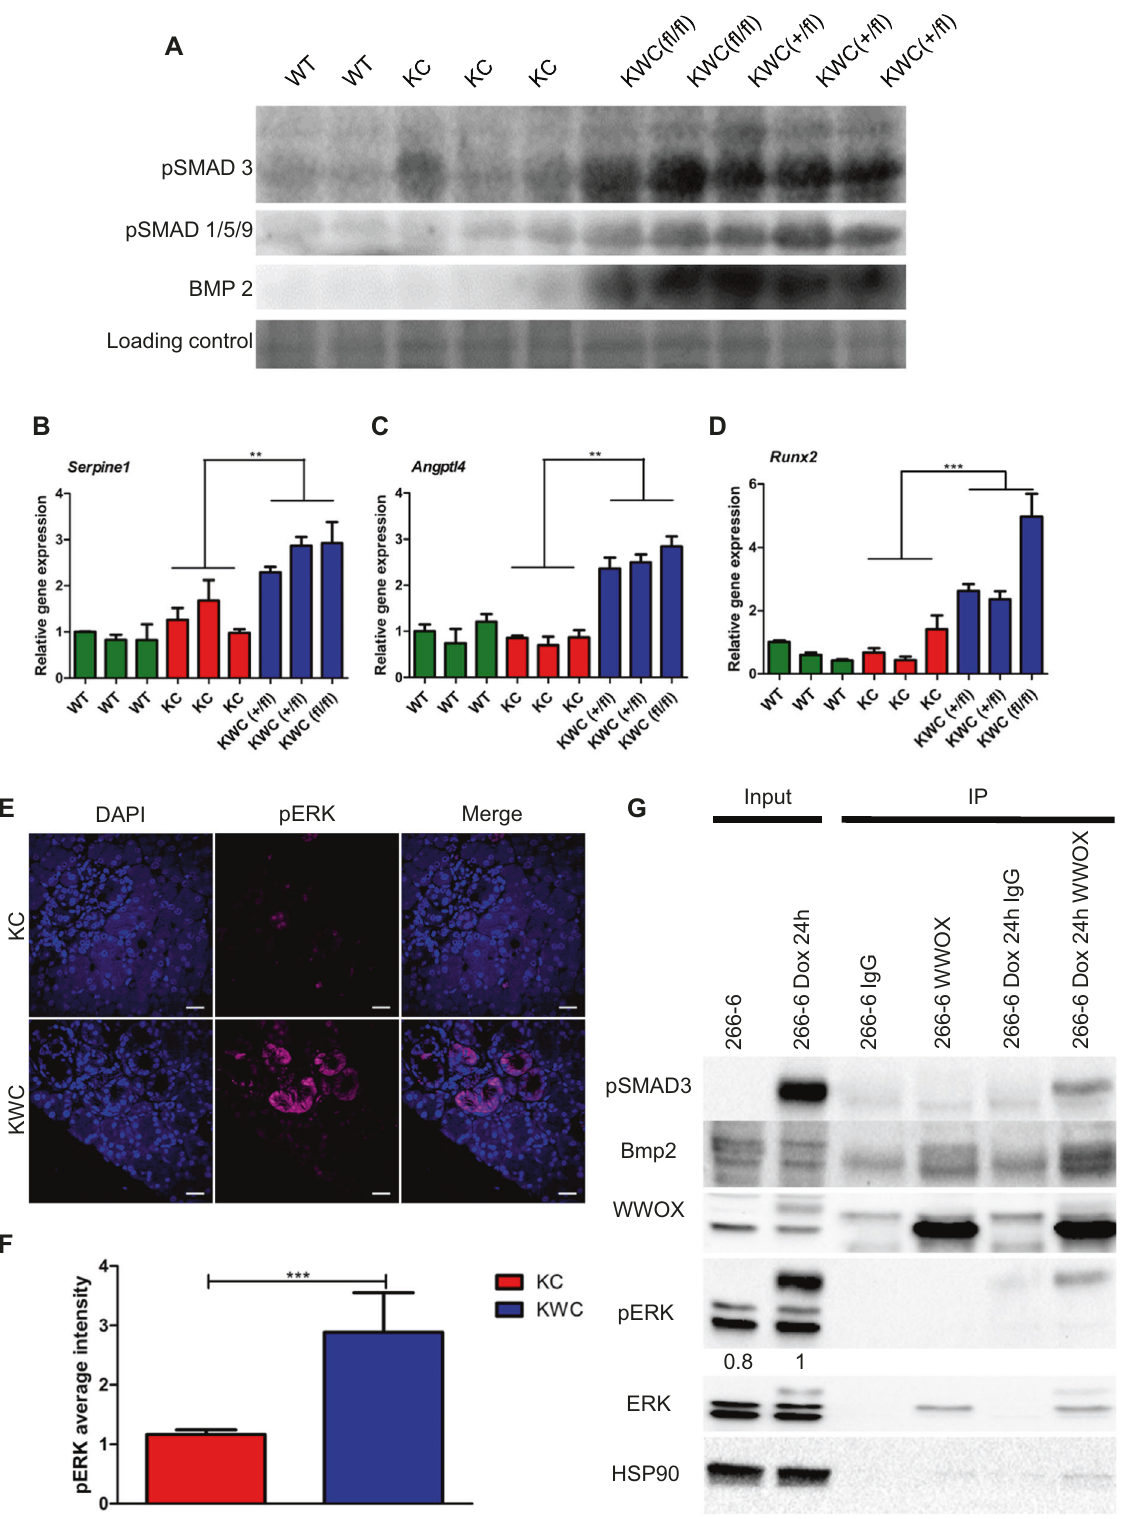
Fig. 4 Wwox deletion promotes TGF β and BMP2 through SMADs signaling. A Immunoblotting of pSMAD 2/3, pSMAD 1/5/9, and BMP2 of WT ( n = 2), KC ( n = 3), KWC Wwoxf/ + ( n = 3), and KWC Wwoxf/f ( n = 2) mice 1-month post-tamoxifen injection. B , C RT-PCR of Serpine1 and Angptl4 of WT, KC, and KWC mice 1-month post-tamoxifen injection. D RT-PCR of Runx2 of WT, KC, and KWC mice 1-month post-tamoxifen injection. E Representative immuno fl uorescence staining of pERK of KC, and KWC mice 1-month post-tamoxifen injection (magni fi cation, ×60). F Quanti fi cation of pERK staining of KC ( n = 4) and KWC ( n = 5). G Immunoprecipitation of endogenous WWOX from 266-6 cells not activated or activated ( + dox) for 24 h. Whole-cell lysates were immunoprecipitated with either rabbit IgG (control) or monoclonal WWOX mouse antibodies. The immunoprecipitants were immunoblotted with anti-WWOX, anti-pSMAD 2/3, anti-pERK, anti-ERK, and anti-BMP2/4 as indicated. ** P < 0. 001, *** P < 0. 0001. Two-tail unpaired t -test. Quanti fi cation graphs are presenting the means ±